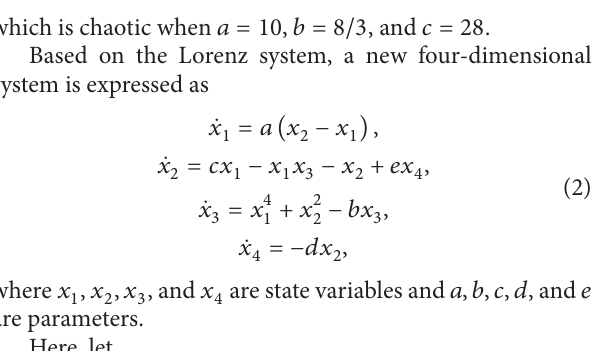
Figure 3: The Lyapunov exponent